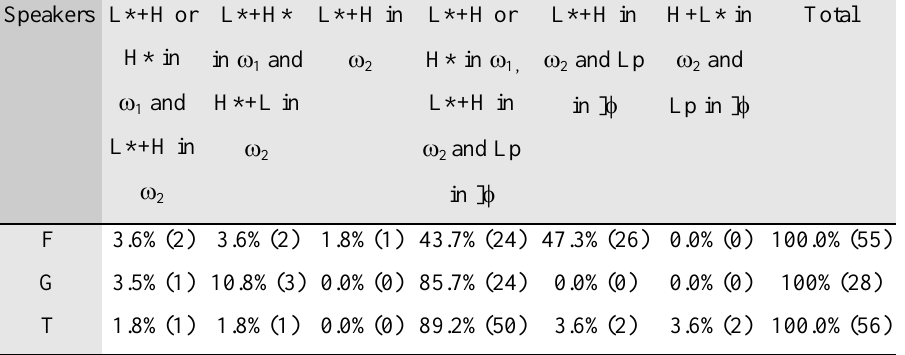
Table VII. Tonal events associated with the initial contour of the sentences with narrow-focus on the subject, in which the subject forms a branching